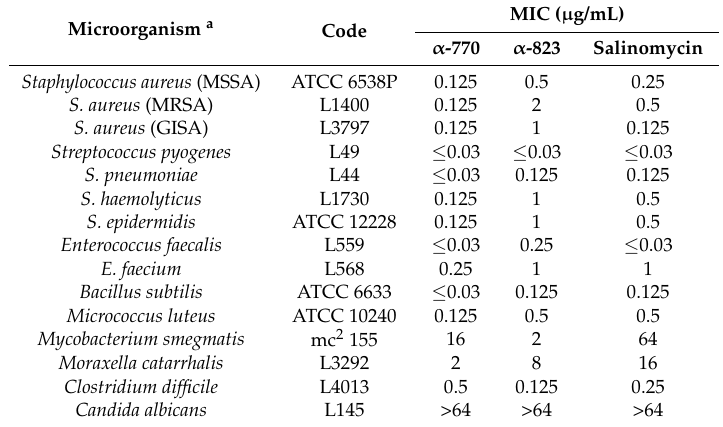
Table 3. MICs (Minimal Inhibitory Concentrations) of α -770 and α -823 in comparison with salinomycin. MIC ( µ g/mL) Microorganism a Code α